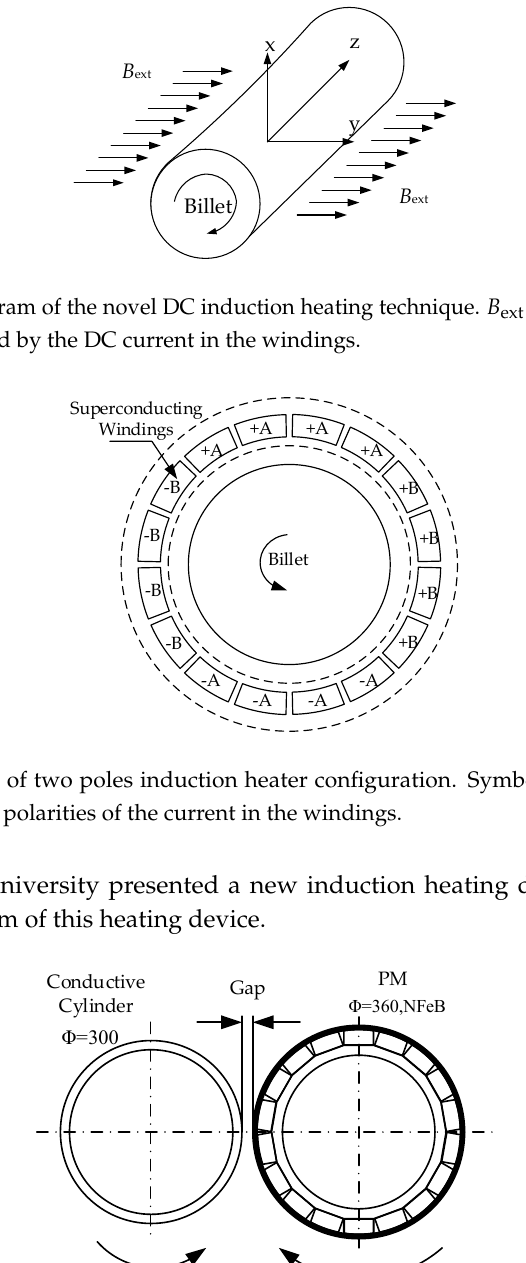
Figure 4. Structure diagram of the new induction heating device developed in Oita University.